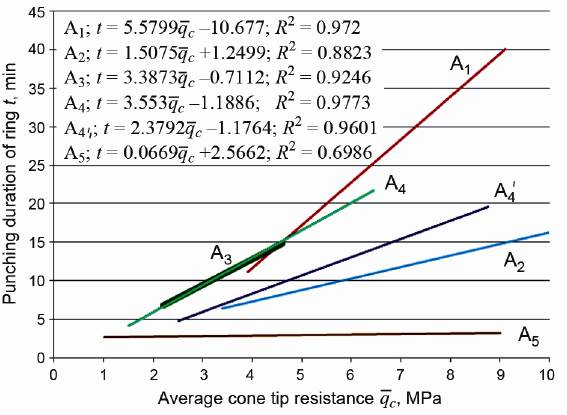
Fig. 6. Influence of soil conditions on the ring punching time, using the linear dependence regression equation